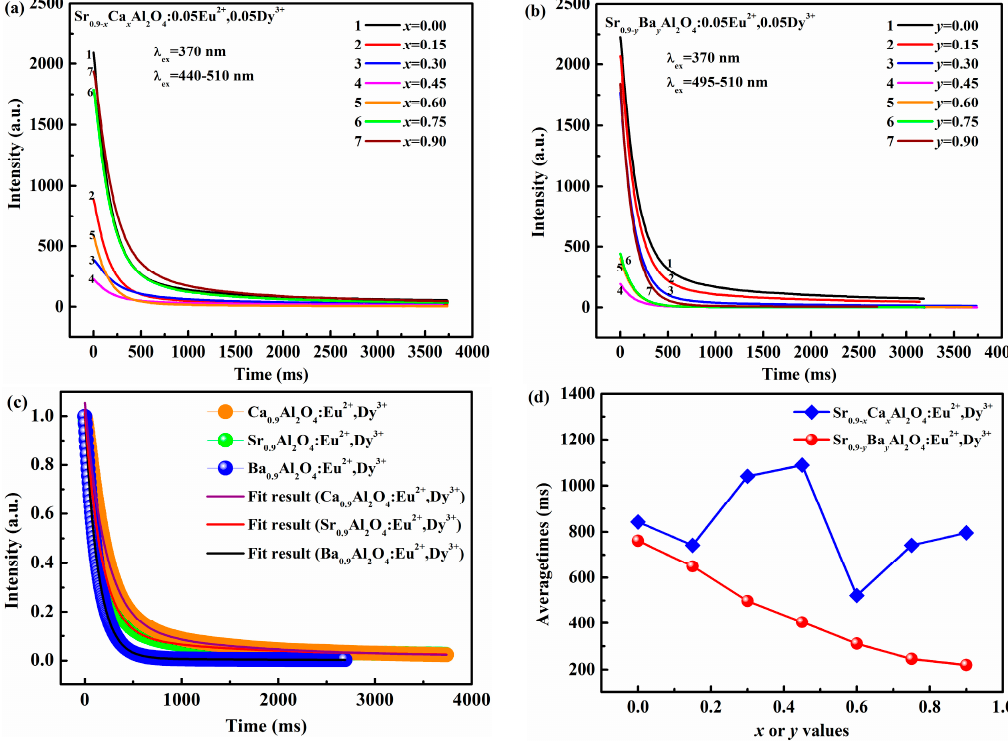
Figure 4. ( a ) Photoluminescence decay curves ofSr 0.90 − x Ca x Al 2 O 4 :0.05Eu 2+ , 0.05Dy 3+ with various x (Ca 2+ ) ( λ ex = 370 nm λ em = 440–510 nm); ( b ) photoluminescence decay curves of Sr 0.90 − y Ba y Al 2 O 4 :0.05Eu 2+ , 0.05Dy 3+ with various y (Ba 2+ ) ( λ ex = 370 nm λ em = 495–510 nm); ( c ) normalized decay and fitted curves of phosphors (Ca 0.90 Al 2 O 4 :0.05Eu 2+ , 0.05Dy 3+ , Sr 0.90 Al 2 O 4 :0.05Eu 2+ , 0.05Dy 3+ , Ba 0.90 Al 2 O 4 :0.05Eu 2+ , 0.05Dy 3+ ); ( d ) average lifetimes of Sr 0.90 − x Ca x Al 2 O 4 :0.05Eu 2+ , 0.05Dy 3+ , and Sr 0.90 − y Ba y Al 2 O 4 :0.05Eu 2+ ,